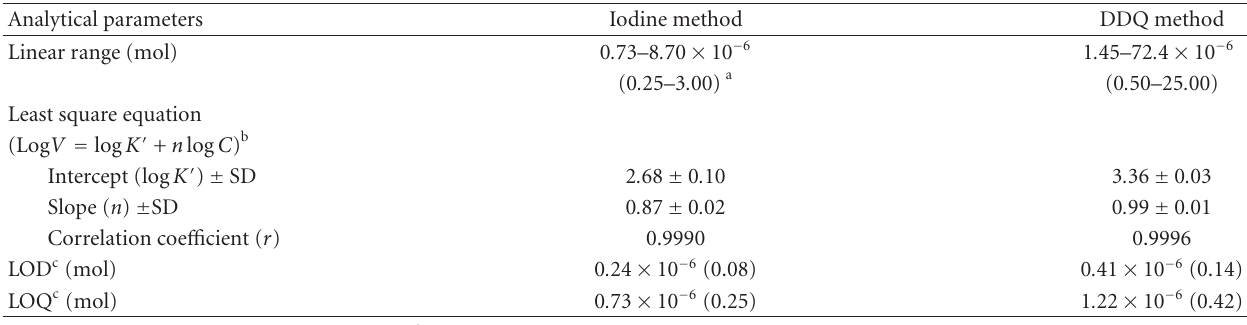
Table 3: Analytical parameters for the proposed kinetic initial rate methods for determination of OMZ.